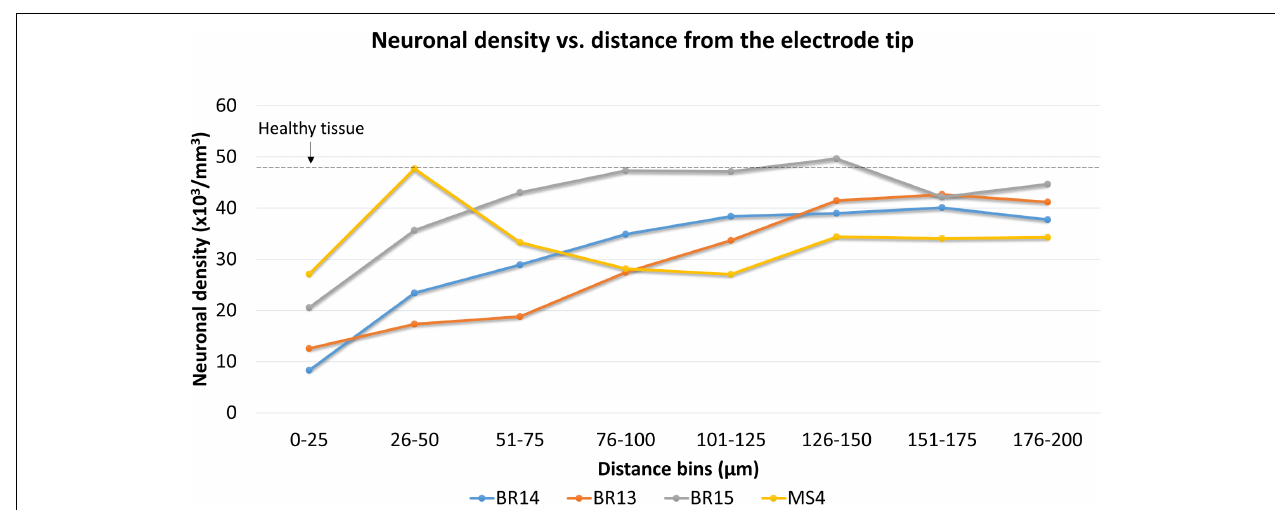
FIGURE 12 | Neuronal density for three Blackrock electrode tips and one short microwire electrode tip. For Blackrock electrodes (BR), neuronal densities increased with distance from the electrode surface. For the microwire electrode (MS), neuronal density was higher than the Blackrock electrodes in the first 50 µ m, then decreased until it was less than the Blackrock electrodes from 100–200 µ m. Dashed line represents the neuronal density measured in healthy tissue far from the electrode tracks at the same